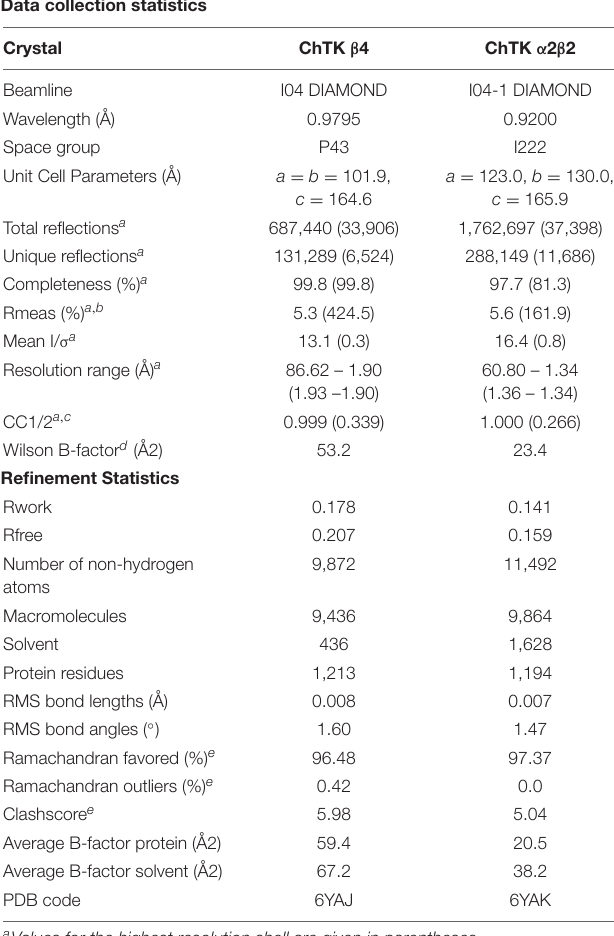
TABLE 1 | Summary of crystallographic